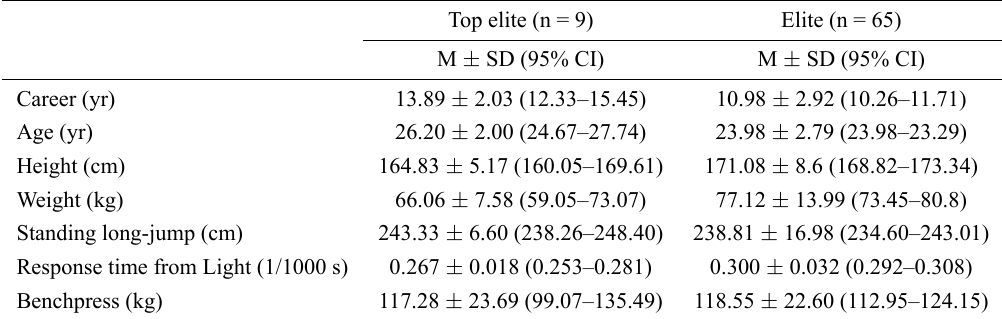
Table 2. Subjects’ characteristics of Top elite and elite Greco-Roman wrestlers. This table shows the characteristics of Top elite (n = 9) and elite (n = 65) Greco-Roman